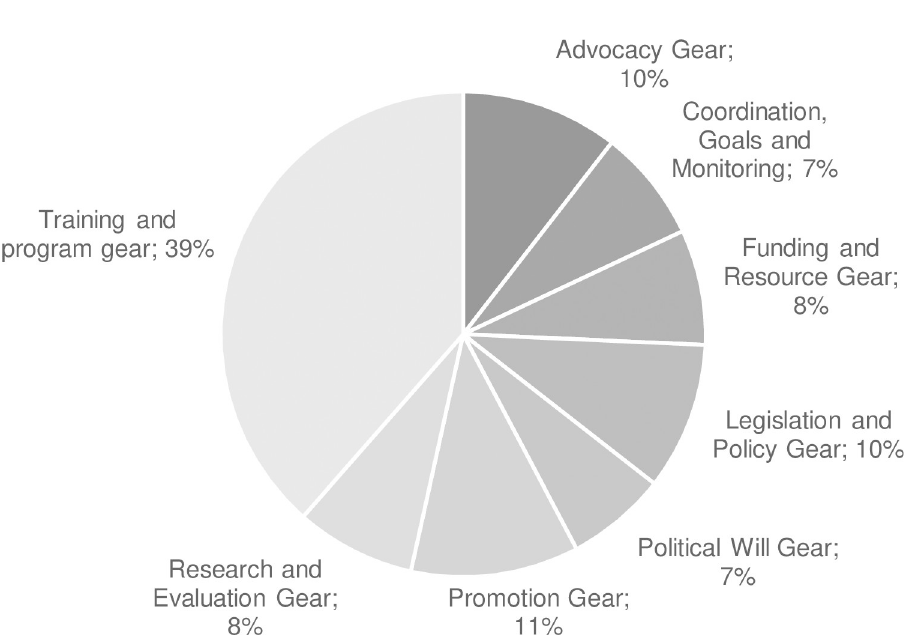
Fig 3. Percent of words discussing each BBF Gear from all meeting transcripts as a proxy of meeting time spent discussing each gear.